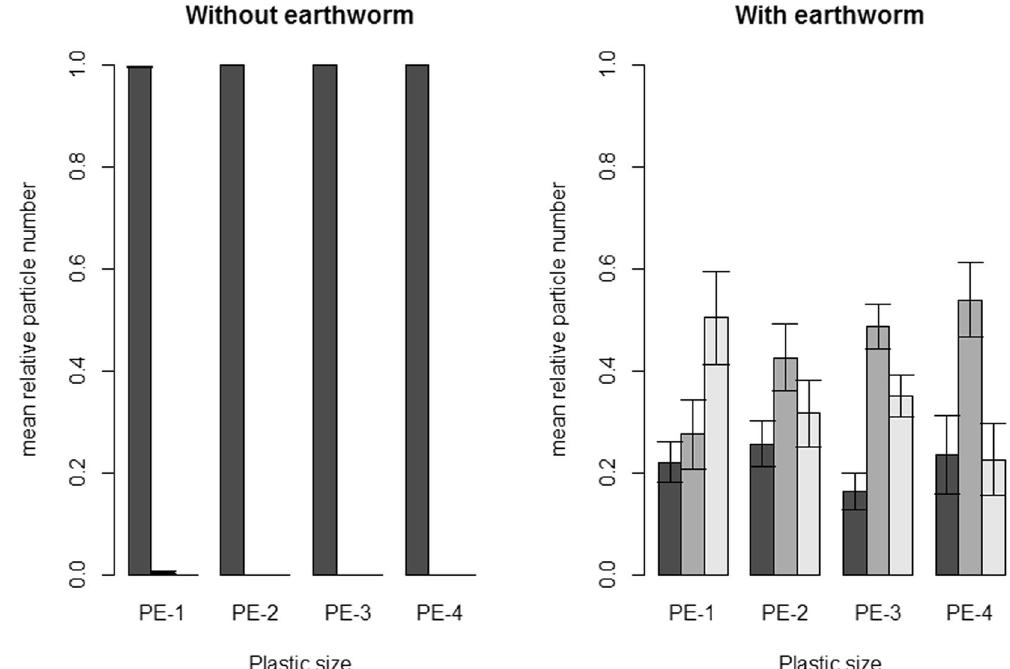
Figure 2. Distribution of the mean relative microplastic particle numbers (expressed as a percentage of all particles retrieved in the cores per pot) among the different soil layers, error bars indicate standard errors. The left panel shows data in the absence of earthworms, the right panel with earthworms. Dark grey bars show data for the top soil layer, while medium and light grey bars show data for the middle and bottom layer, respectively. Results are shown for four different particle size ranges: 710–850 μ m (PE-1), 1180–1400 μ m (PE-2), 1700– 2000 μ m (PE-3) and 2360–2800 μ m (PE-4).